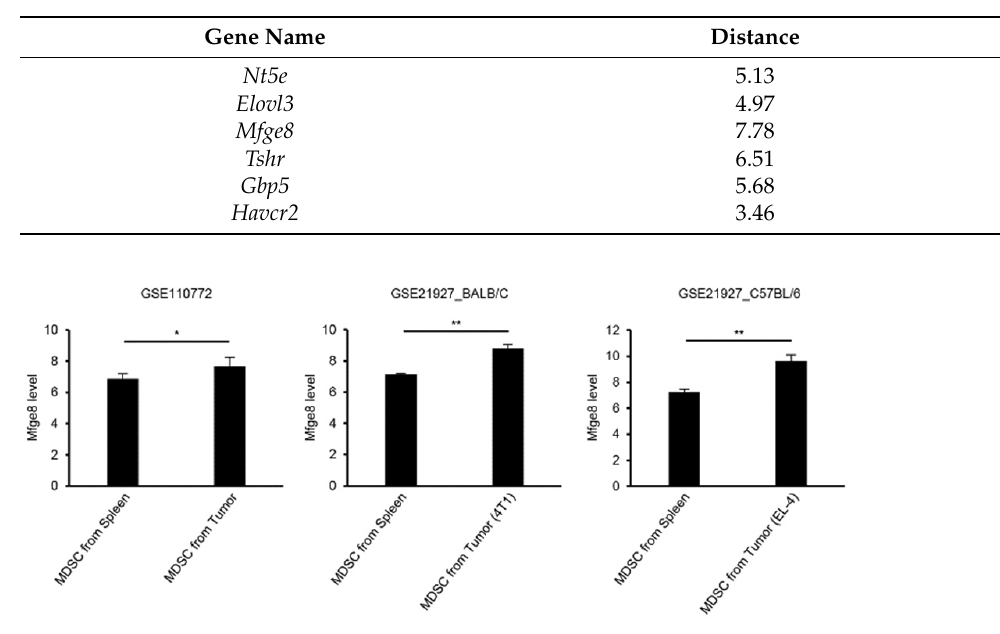
Table A1. ‘Distance’ values of six candidate genes. ‘Distance’ values of six genes were calculated based on the qPCR results.